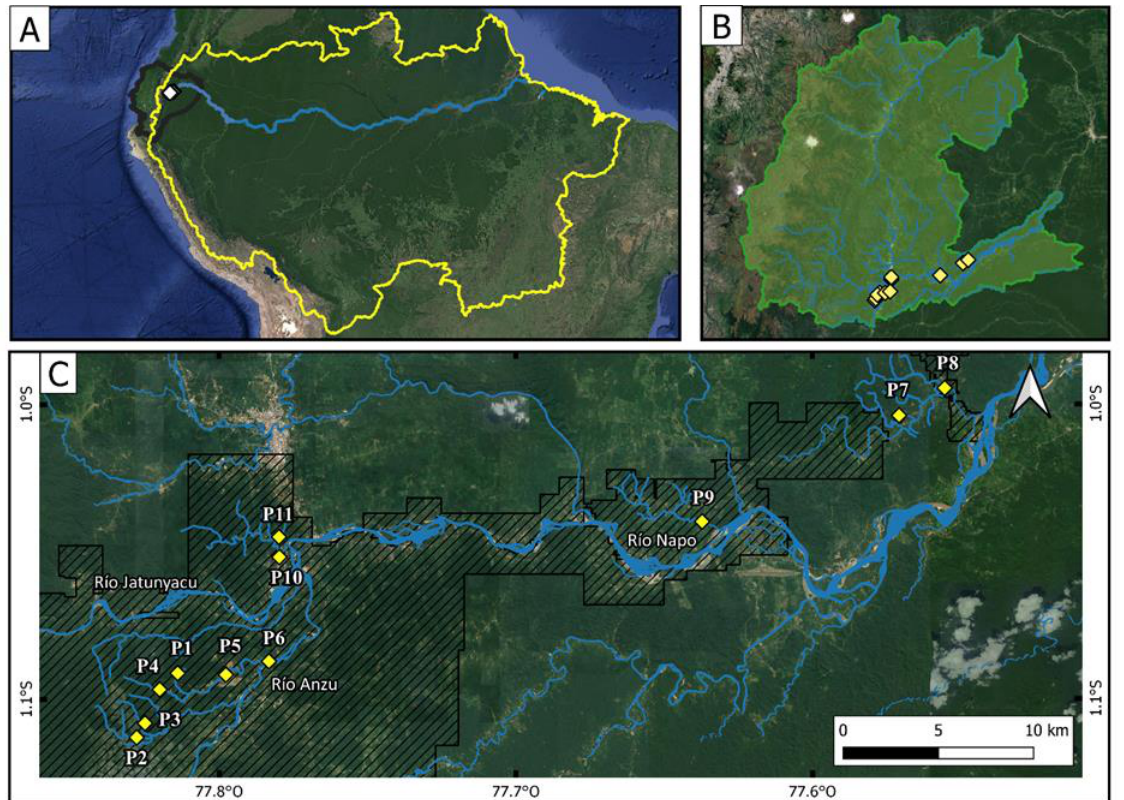
Figure 1. ( A ) Location of the study area in the Amazon basin. ( B ) Napo province of Ecuador and location of the sampling sites (yellow diamonds). ( C ) Detailed distribution of the sampling sites (yellow diamonds). Dashed polygons show the total area under concession for gold mining activities according to [14].